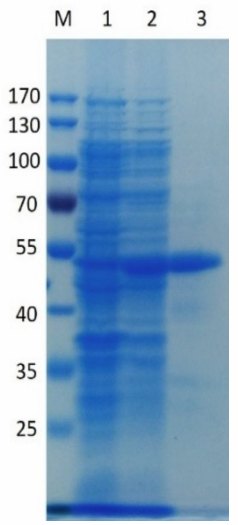
Figure 2. Molecular weight of PpPel9a determined by SDS-PAGE: (M) protein molecular weight markers (PageRuler Prestained Protein Ladder, Thermo Scientific) (1) supernatant of cell lysis from E. coli BL21 (DE3) cells; (2), supernatant of cell lysis from recombinant E. coli BL21 (DE3) cells harboring pET-28a-pppel9a plasmid; (3) recombinant enzyme PpPel9a purified from Ni-NTA agarose